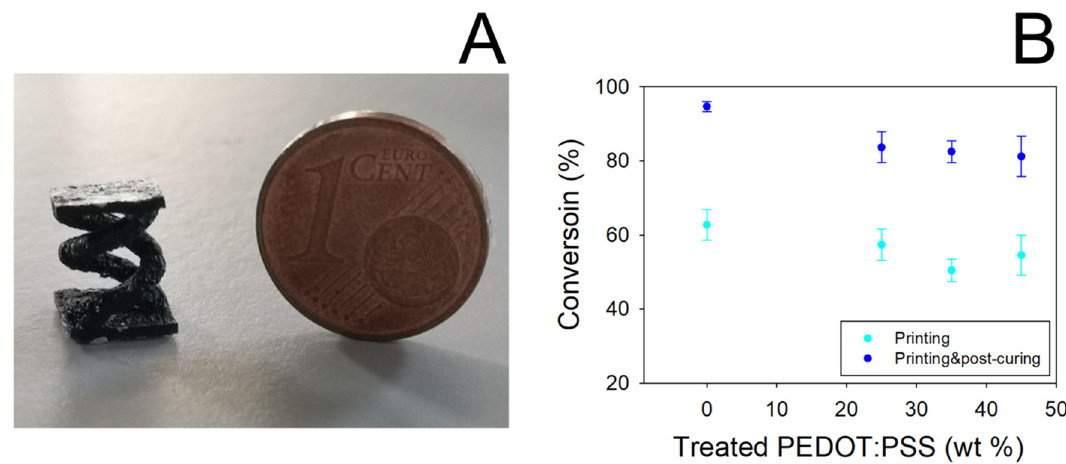
Figure 2. ( A ) 3D-printed double helical sample from PEGDA:PEDOT resin (printing parameters 50 mW laser power, 2000 mm s − 1 scan velocity). ( B ) Conversion yield of PEGDA as a function of treated PEDOT:PSS concentration. Data were obtained by FT-IR spectroscopy analysis on 3D-printed samples before and after the post-curing process.